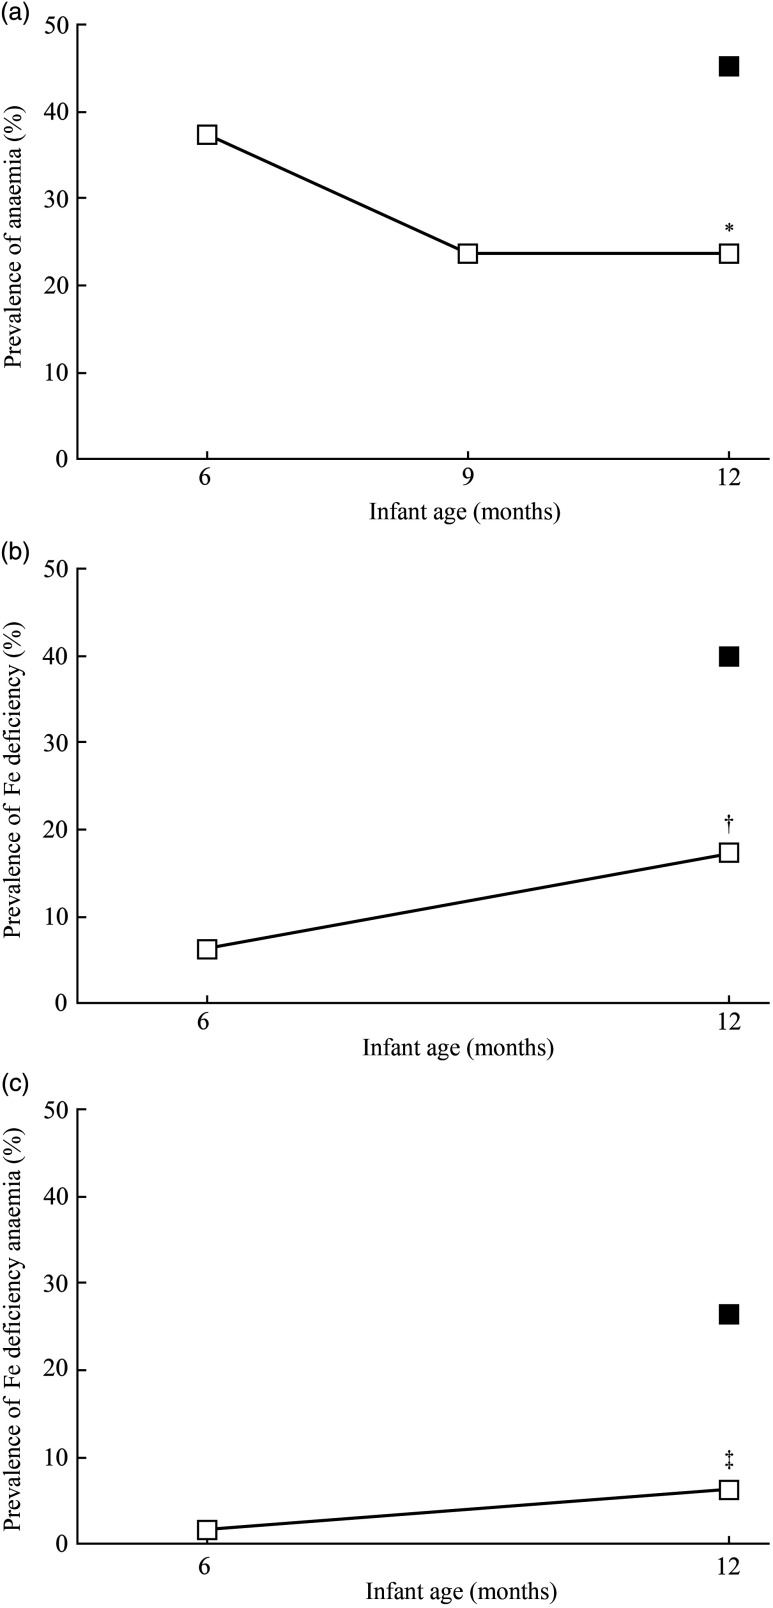
Prevalence of anaemia (a), iron deficiency (b) and iron-deficiency anaemia (c) at 6 and 12 months of age for infants in the intervention group (IC; n 64) and at 12 months of age for infants in the static cross-sectional control group (CG; n 80). , CG; , IC. Significantly different from CG using Pearson’s χ
2 test: * P = 0·007; † P = 0·003; ‡ P = 0·002. Anaemia defined as Hb <110 g/l; iron deficiency defined as serum ferritin <12 μg/l and C-reactive protein (CRP) < 5 mg/l or serum ferritin <30 μg/l and CRP ≥ 5 mg/l; iron-deficiency anaemia defined as Hb <110 g/l and serum ferritin <12 μg/l and CRP < 5 mg/l or Hb <110 g/l and serum ferritin <30 μg/l and CRP ≥ 5 mg/l.